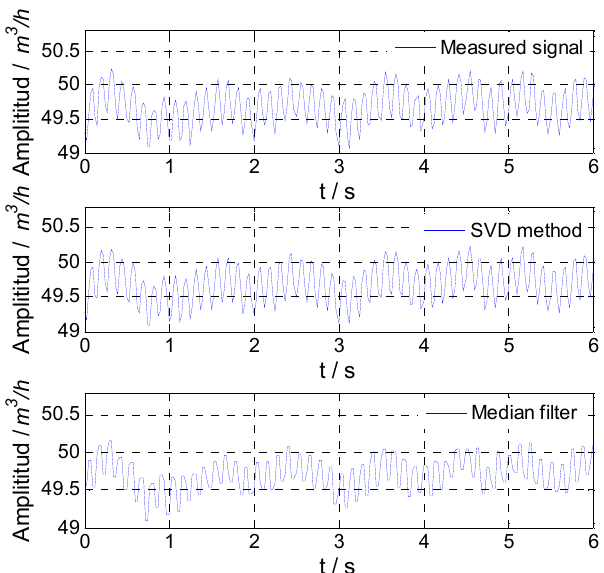
Figure 14. Experimental result for experiment No. 3.